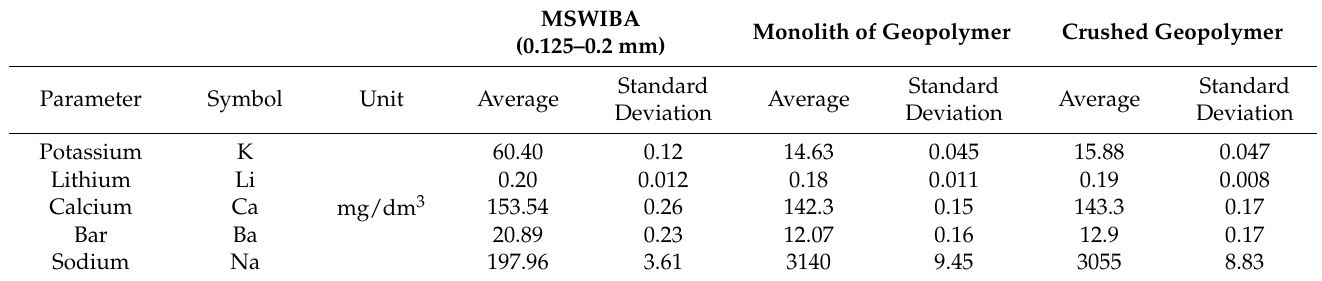
Table 6. Leachability of MSWIBA, a monolith of geopolymer, and crushed